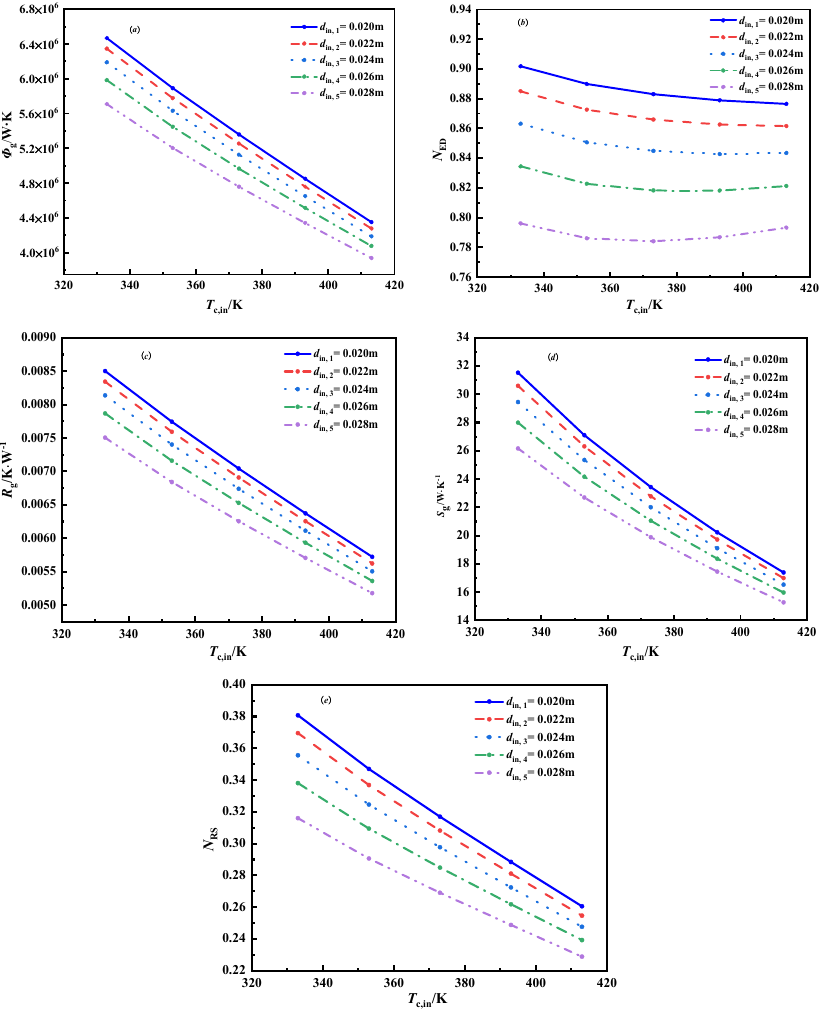
Figure 7. The 𝜙 ( a ), 𝑁 ED ( b ), 𝑅 g ( c ), 𝑆 g ( d ), and 𝑁 (cid:2902)(cid:2903) ( e ) versus the inner diameter. Figure 7. The φ g ( a ), N ED ( b ), R g ( c ), S g ( d ), and N RS ( e ) versus the inner g